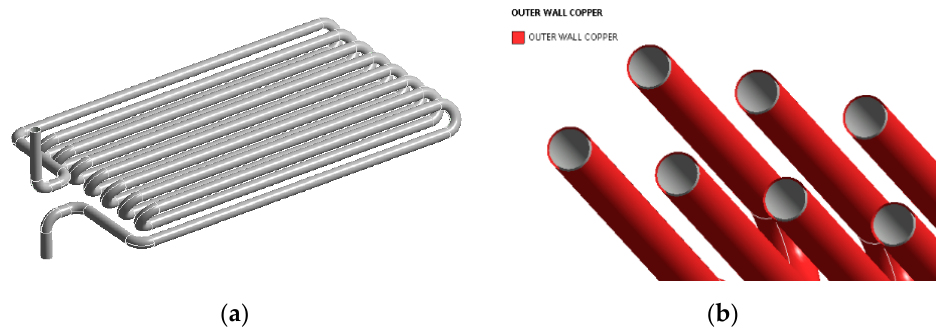
Figure 7. ( a ) Aluminium Radiator (Before coating) and ( b ) Copper Coated Cut Section View.